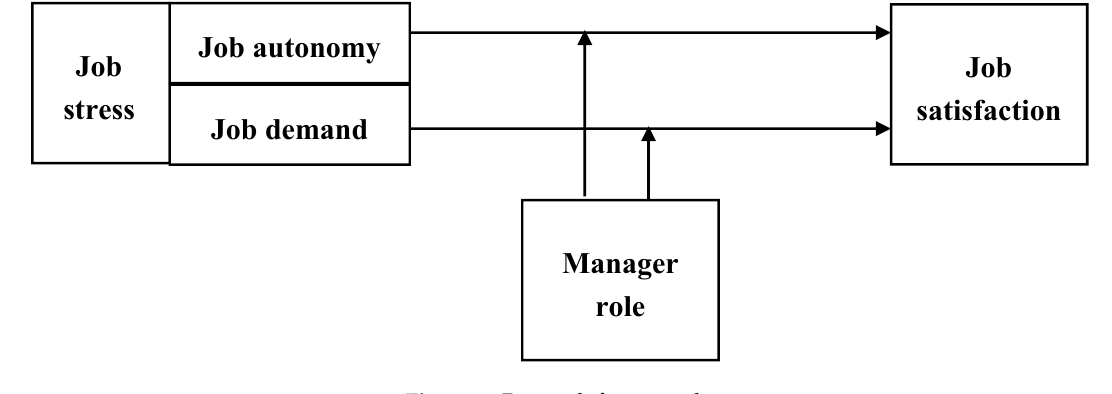
Figure 1. Research framework.